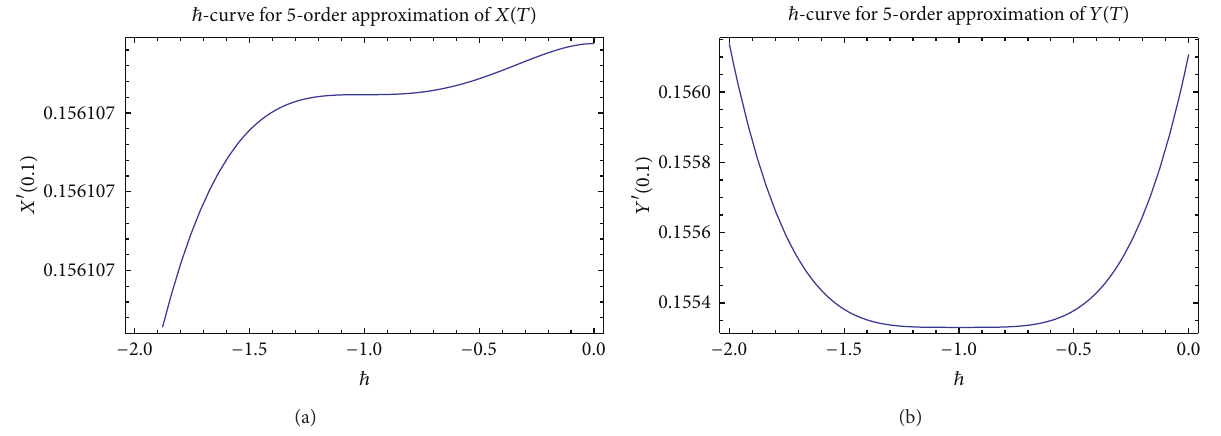
Figure 2: The ℏ -curves of 𝑋 󸀠 (0.1) and 𝑌 󸀠 (0.1) obtained by the 5-order approximation of HAM.